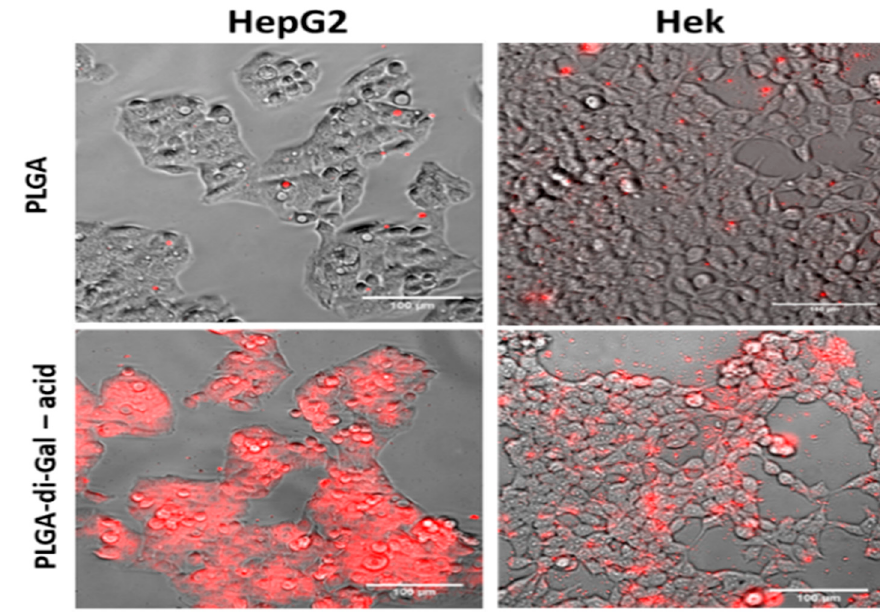
Figure 7. HepG2/C3A and HEK 293T cells after 24 h incubation with different NPs loaded with rhodamine B: Images are composites of fluorescence (rhodamine, red) and phase contrast images. The bars represent 100 μ m.